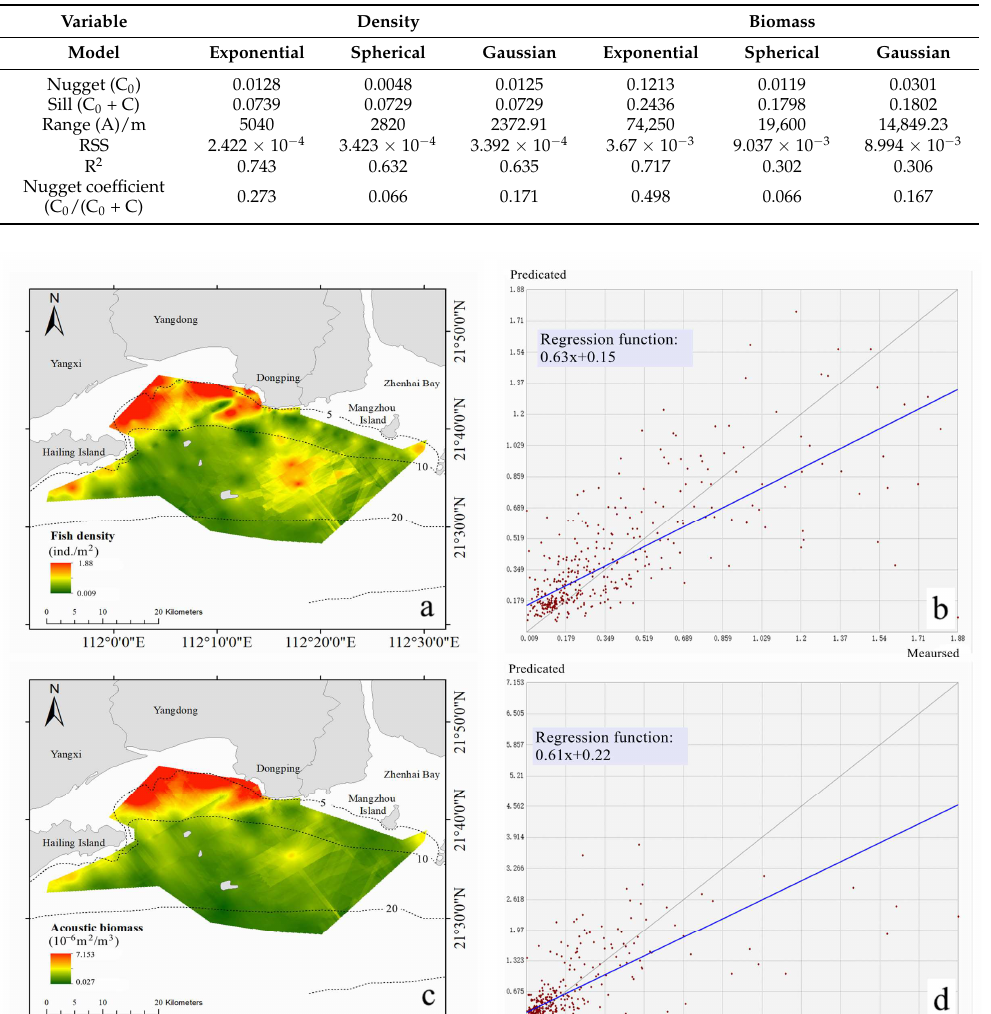
Table 4. Parameters of semi-variance function models.